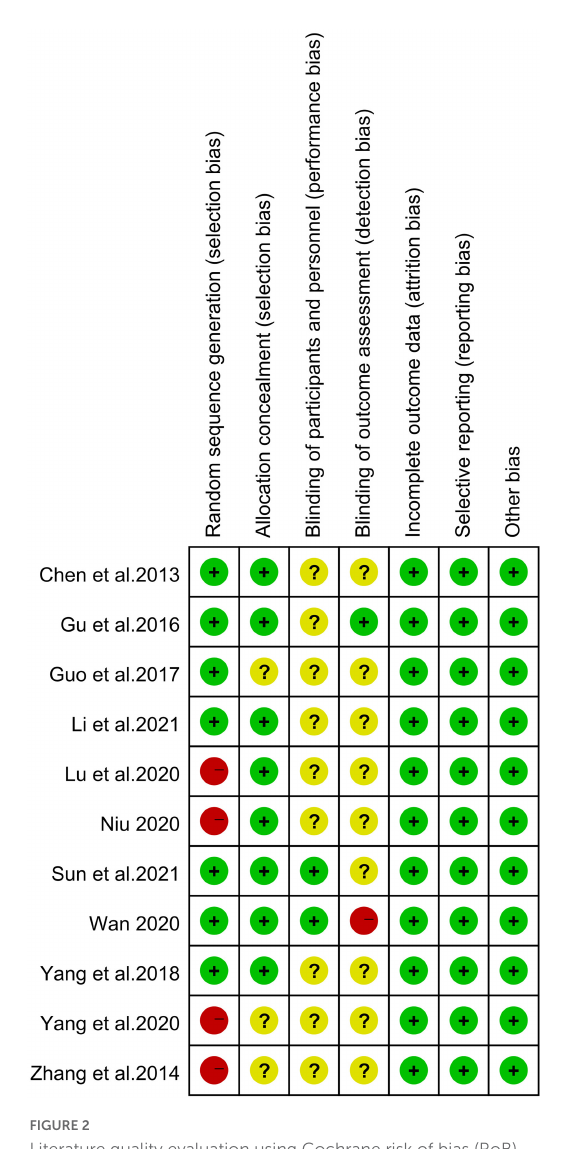
FIGURE2 Literature quality evaluation using Cochrane risk of bias (RoB) assessment